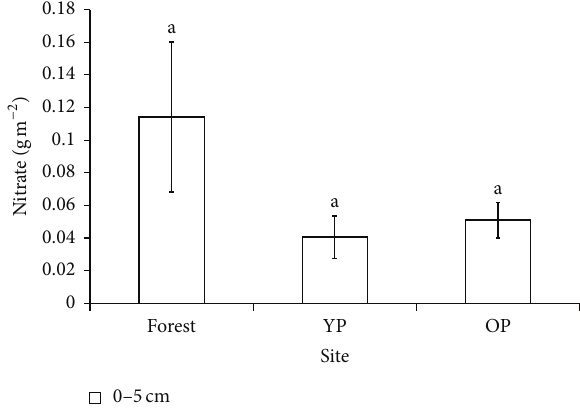
Figure 3: Mineralized nitrate accumulated during 15 weeks of the incubation experiment in laboratory conditions in forest and pas- tures’ soils. Mean values with standard error bars across forest and pastures. Different lowercase letters indicate significant differences between sites ( 𝑃 < 0.05 ). YP: 5-year-old pasture; OP: 18-year-old